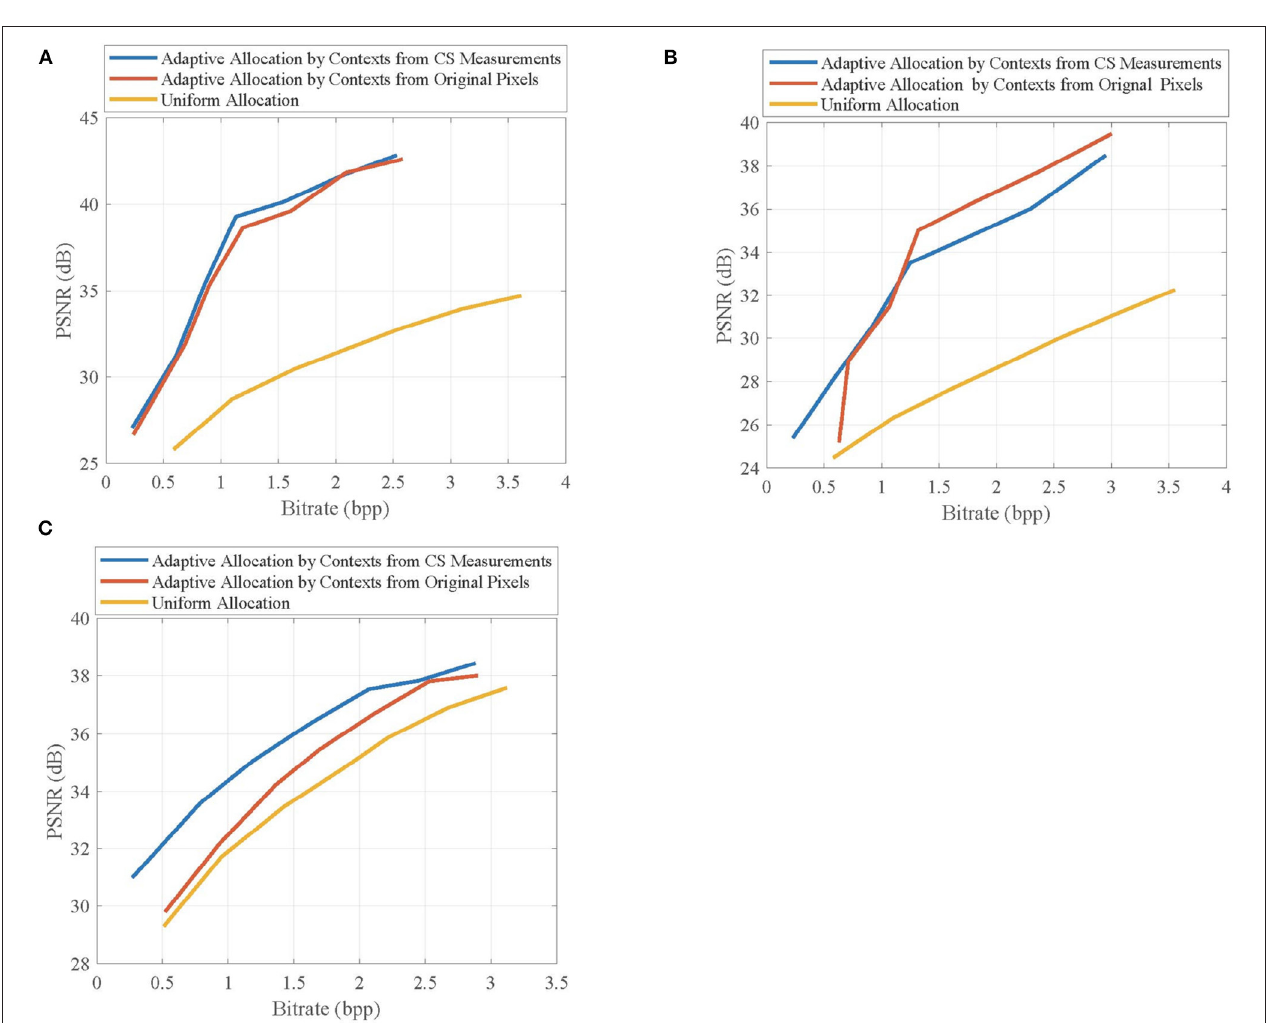
FIGURE 9 | Rate-distortion curves of the reconstructed key frames in (A) Foreman , (B) BlowingBubbles , and (C) ParkScene sequences when using different allocation schemes. For Foreman and BlowingBubbles , the block-size pair is set to be (2,16), and for ParkScene , the block-size is set to be (8,16).